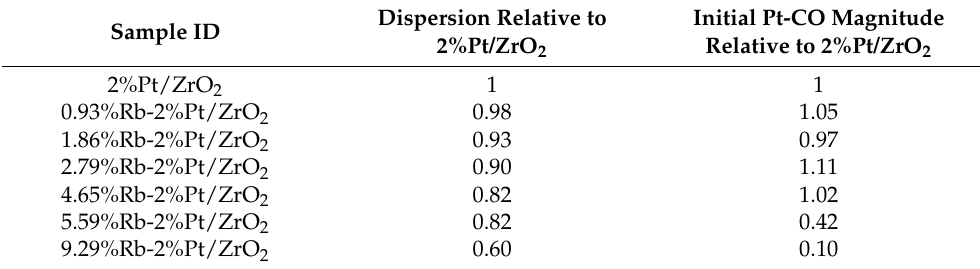
Table 4. Dispersion and initial Pt-CO band magnitude relative to 2%Pt/ZrO